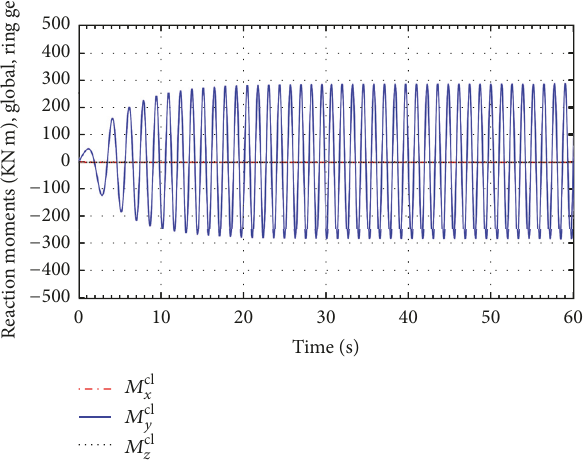
Figure 12: Reaction moments in global coordinates of ring